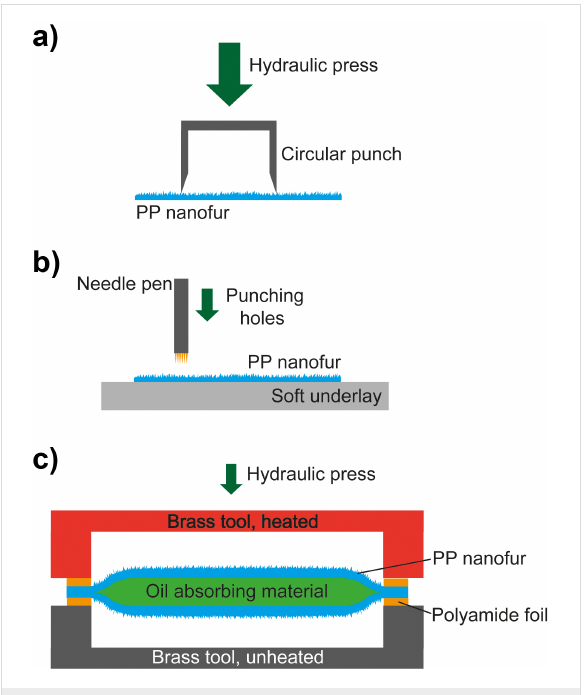
Figure 8: Schematic of the nanopad fabrication steps. (a) First, circu- lar cut-outs are produced using a circular punch. (b) These pieces are perforated by punching holes with a needle pen. A soft underlay guar- antees that the needles penetrate the film completely. (c) Two cut-outs are filled with oil-absorbing material, placed between polyimide masks, and heat-welded using a heated brass tool. Finally, the uneven edge is cut off with a circular punch giving the nanopad a round